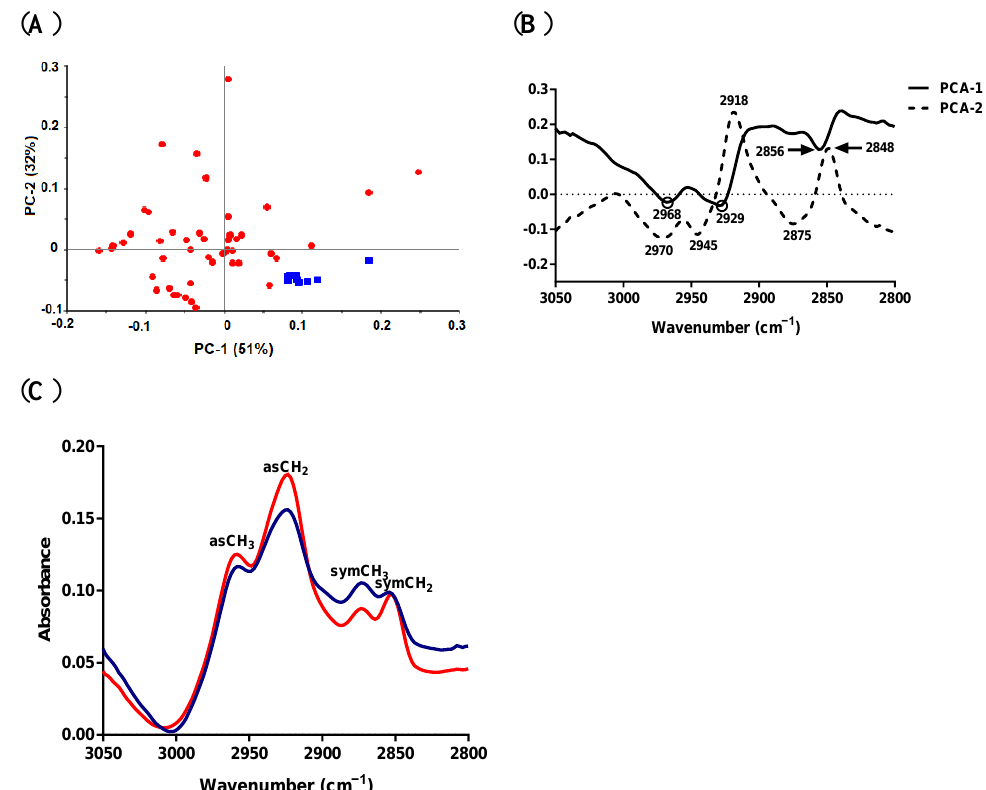
Figure 5. SR-FTIR spectra of the average lipid region from S. epidermidis SCV (NSCV, ASCV and LSCV; red) and S. epidermidis ATCC 12228 (blue). ( A ) PCA score plot. ( B ) Loading plot of PC-1 and PC-2 of PCA model. ( C ) Unit-vector-normalized average raw spectra of lipid peaks and unsaturated lipid region.